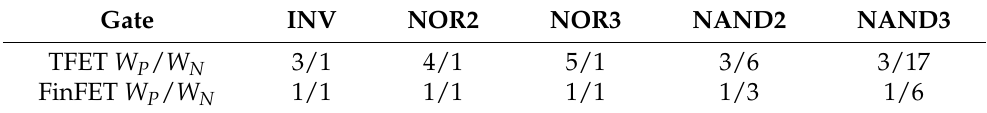
Table 1. W P / W N ratios after the sizing process for an inverter (INV), NOR2, NOR3, NAND2, and